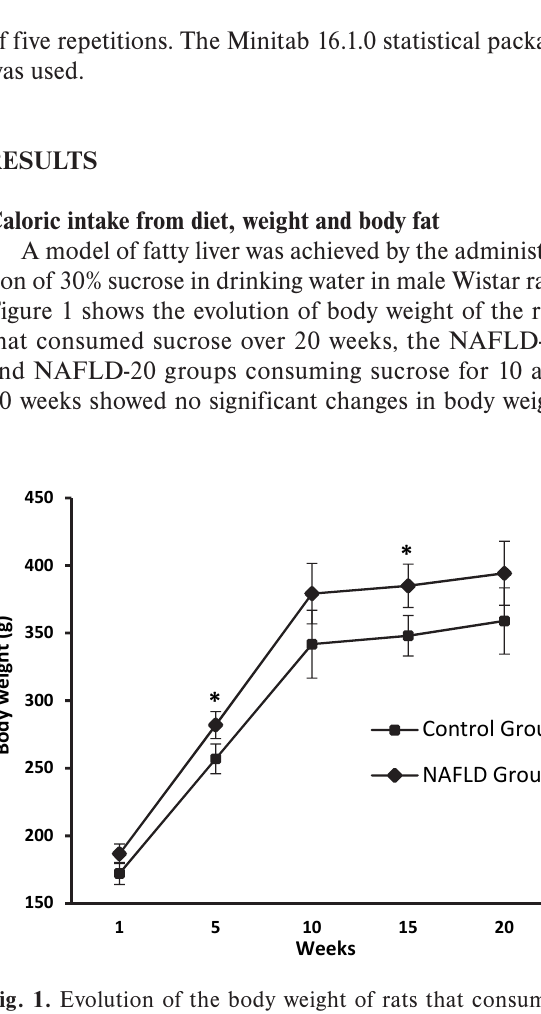
Fig. 1. Evolution of the body weight of rats that consumed sucrose for 10 weeks (NAFLD-10 Group) and 20 weeks (NAFLD-20 Group) with respect to control rats.